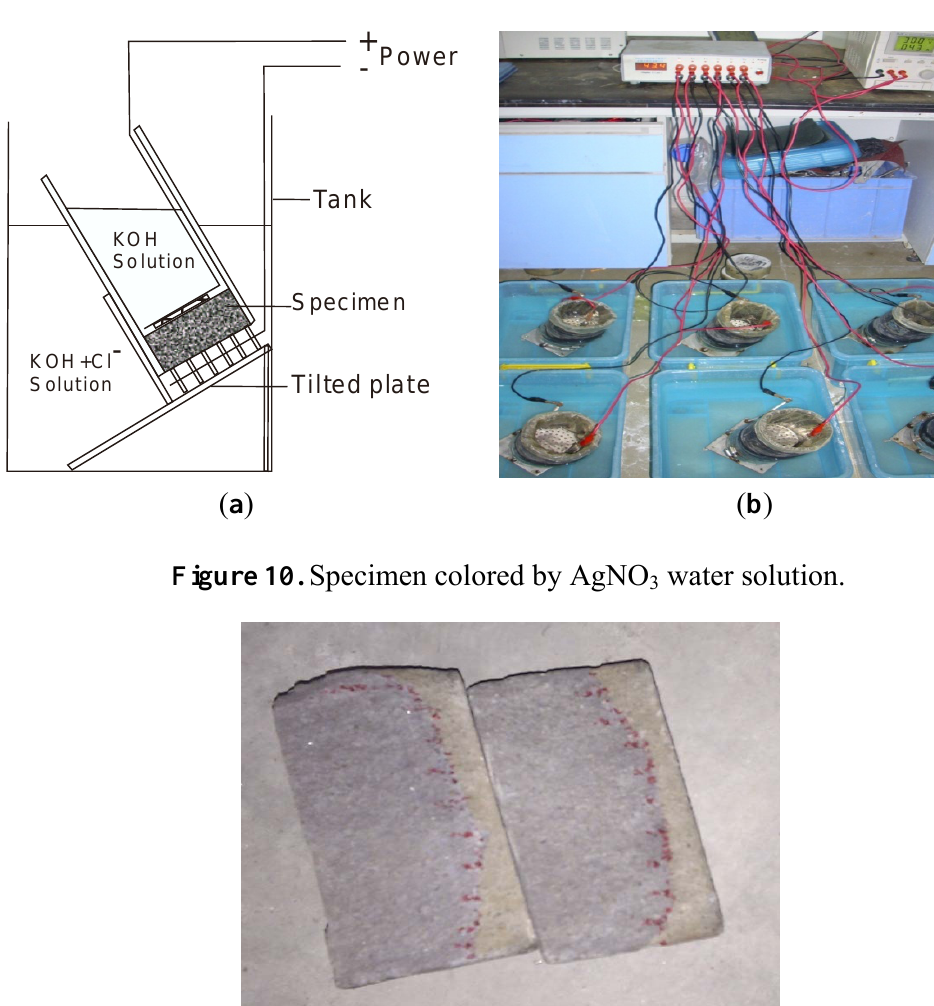
Figure 9. Setup of rapid chloride migration (RCM) test.